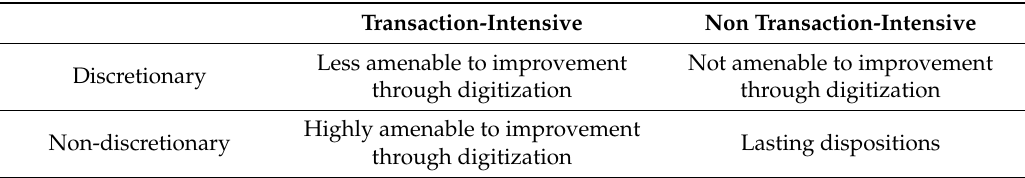
Table 1. Tasks and their amenability to improvement through